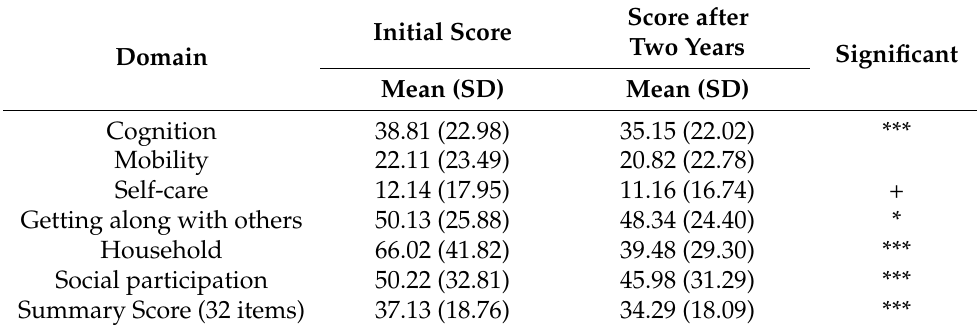
Table 2. The two years difference in performance on the WHODAS2.0 in patients with depression ( n = 1138).